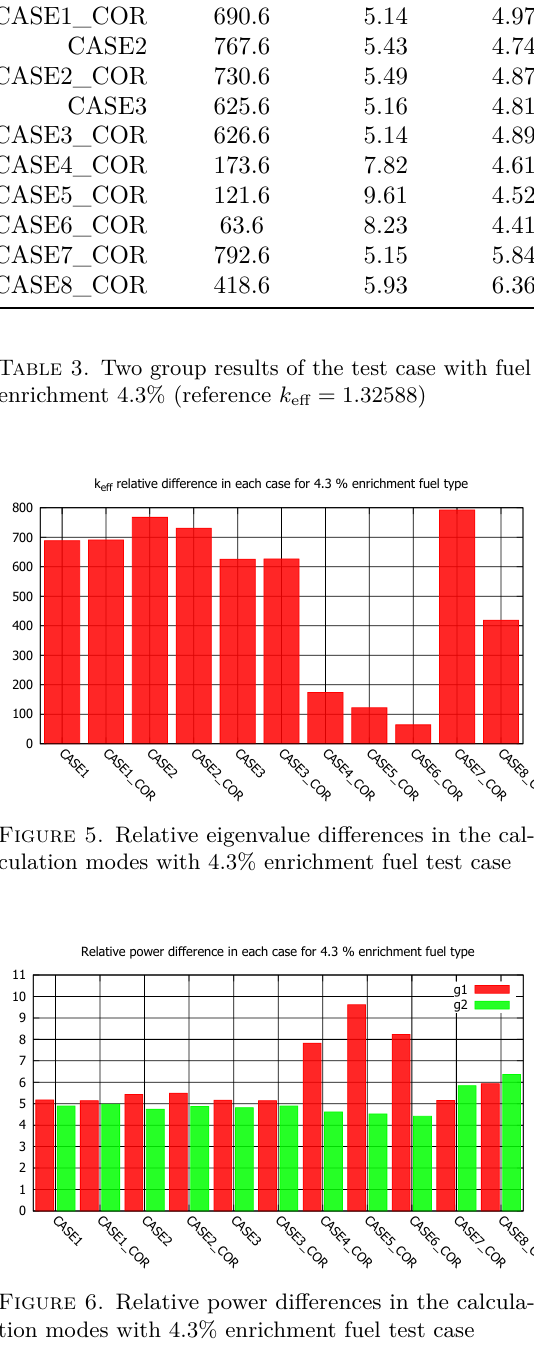
were the highest in that three cases. The 2D flux differences of CASE6_COR is shown in figure 7.